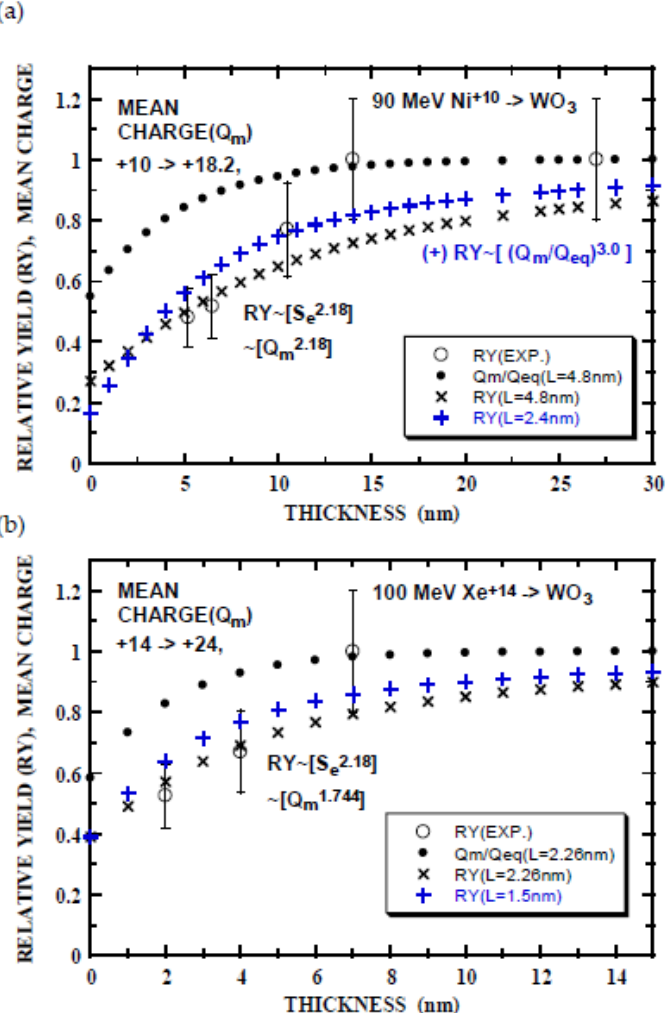
Figure 5. Thickness dependence of relative yield of XRD degradation of WO 3 films irradiated by 90 MeV Ni +10 ( a ) and 100 MeV Xe +14 ions ( b ). Open circles with an error of 20% are the experi- mental yields from Figure 2b. Small closed circles indicate the mean-charge evolution calculated by Equation (2a), for 90 MeV Ni, L = 4.8 nm, Q o = 10 and Q eq = 18.2, and for 100 MeV Xe, L = 2.26 nm, Q o = 14 and Q eq = 24. Relative yield RY is calculated using Equation (3b) (integrand is indicated by []). The parameters of the calculation for 90 MeV Ni ion indicated by x and + are as follows: (x) L = 4.8 nm, n = 2.18 and k = 1.0, and (+) L = 2.4 nm, nk = 3.0 (e.g., n = 2.18 and k = 1.38), respectively. Those for 100 MeV Xe ion are: (x) L = 2.26 nm with nk = 1.744 (n = 2.18 and k = 0.8), and (+) L = 1.5 nm with nk = 1.744 (n = 2.18 and k = 0.8), respectively.